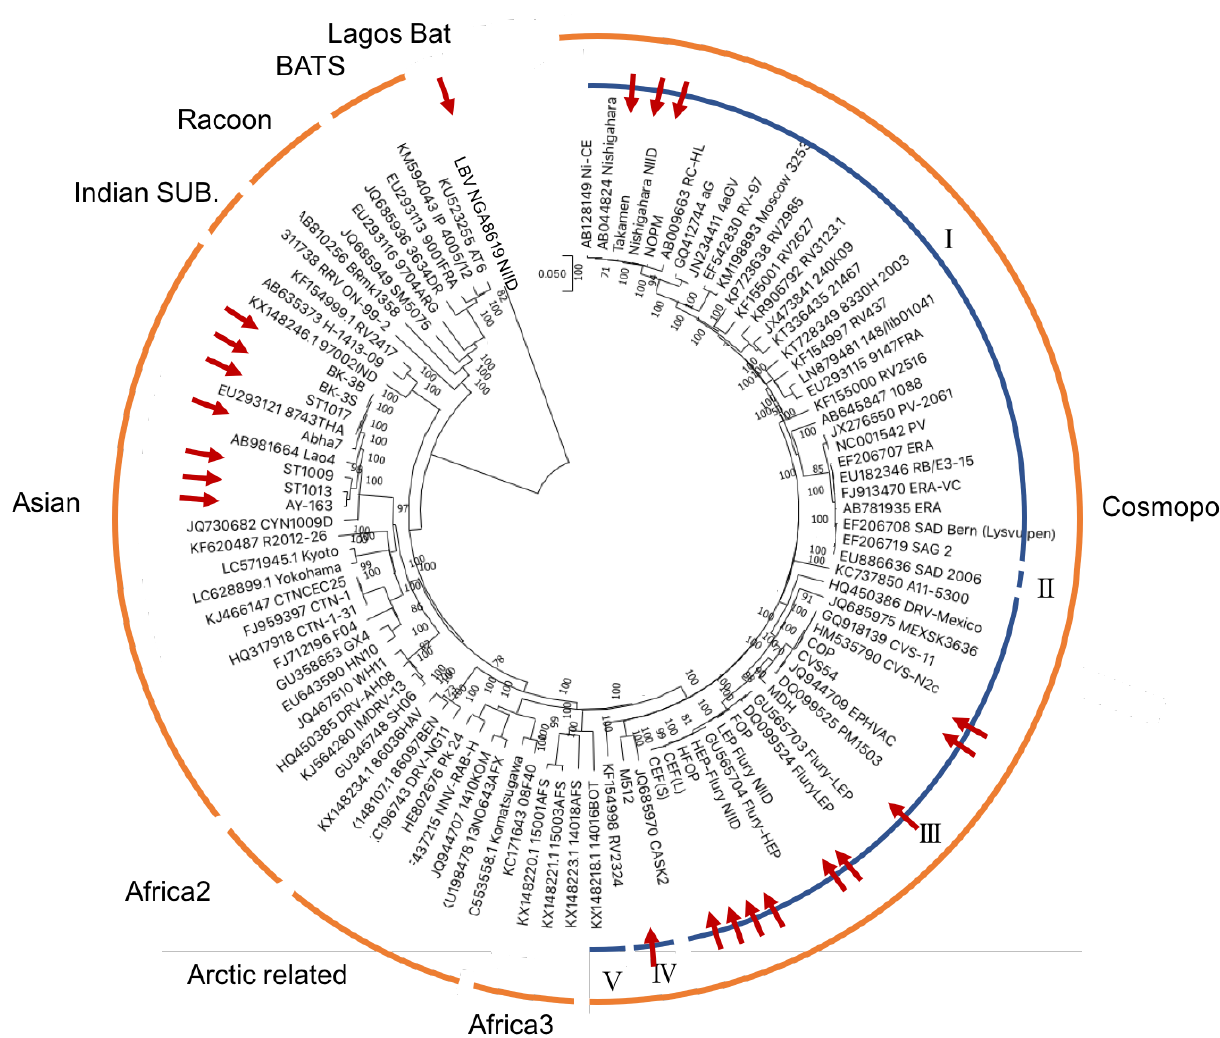
Figure 1. Phylogenetic analysis of rabies strains. Phylogenetic analysis of all coding sequences of 20 rabies strains (analyzed in this study), one Lagos Bat virus, and Gen Bank sequences was performed using the neighbor-joining method and 1000 bootstrap analyses (Mega10.1 software). Chip names are represented by virus names and GenBank accession numbers. Posterior probabilities between 70 and 100% are indicated by numbers. Posterior probabilities below 70% are not indicated. The strains analyzed in this study are marked with red arrows. LBV 8619NGA-NIID was the outgroup. The tree is rooted at the midpoint for clarity and is divided into bat-associated RABVs, including raccoon-skunk clades and bat clades, and dog-associated RABVs, including Africa-2, Arctic-associated, Asian, Indian, and Cosmopolitan clades. The Cosmopolitan clade is divided into five subclades, named Cosmopolitan subclades I – V.